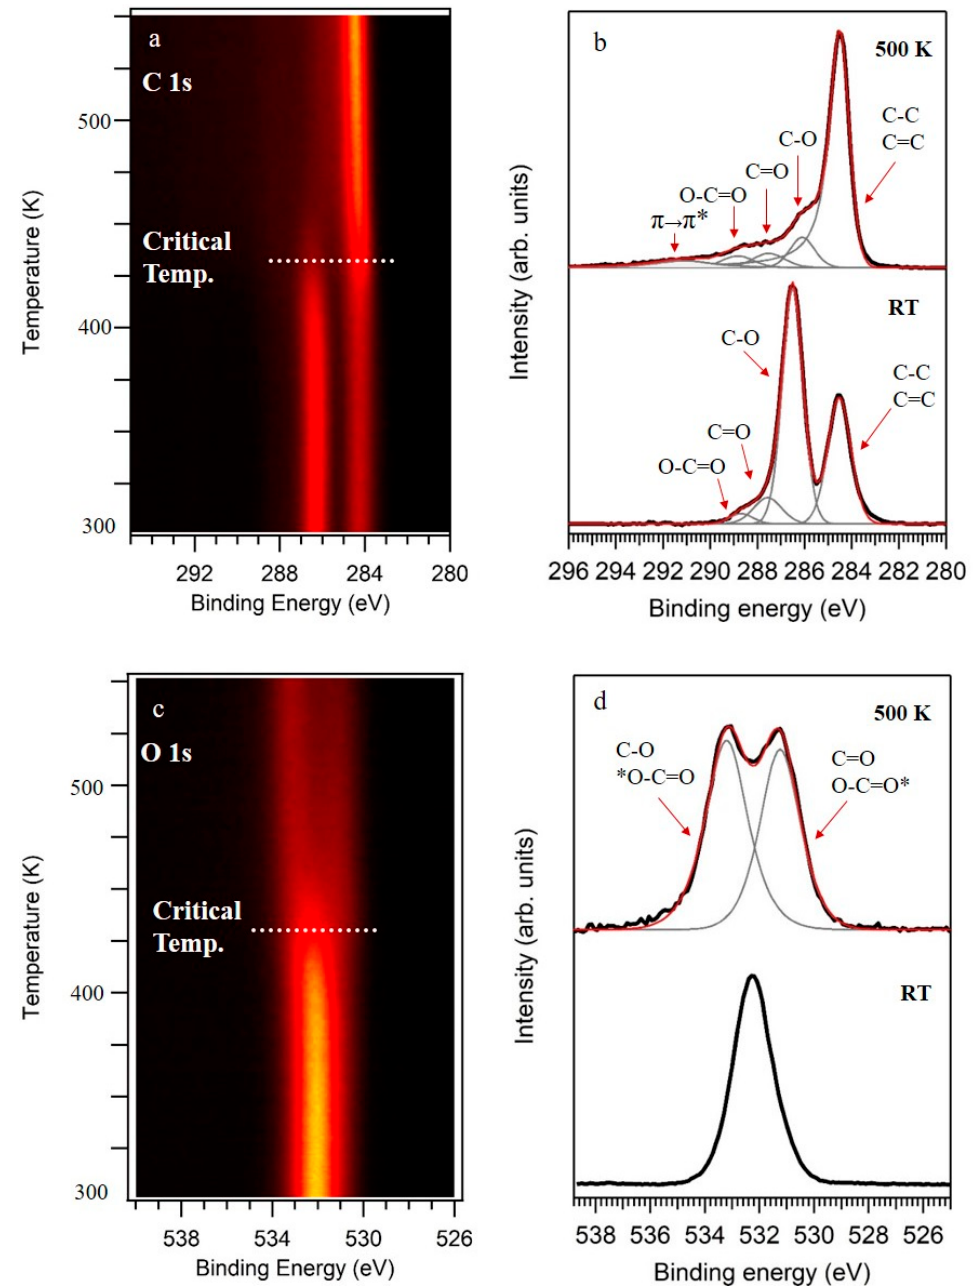
Figure 1. X-ray photoelectron spectroscopy (XPS) spectra of graphene oxide (GO) obtained at RT and their evolution upon annealing. ( a ) C 1s spectra as a function of the temperature of the sample. ( b ) High-resolution C 1s obtained at RT and 500 K. ( c ) O 1s spectra as a function of the temperature of the sample. ( d ) High-resolution O 1s obtained at RT and 500 K. In ( b , d ), the intensities of the spectra were normalized.